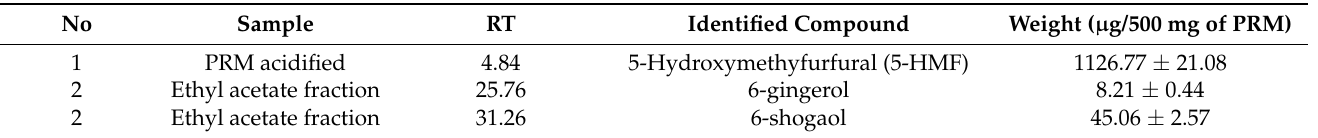
Table 1. Quantitative determination of compounds in